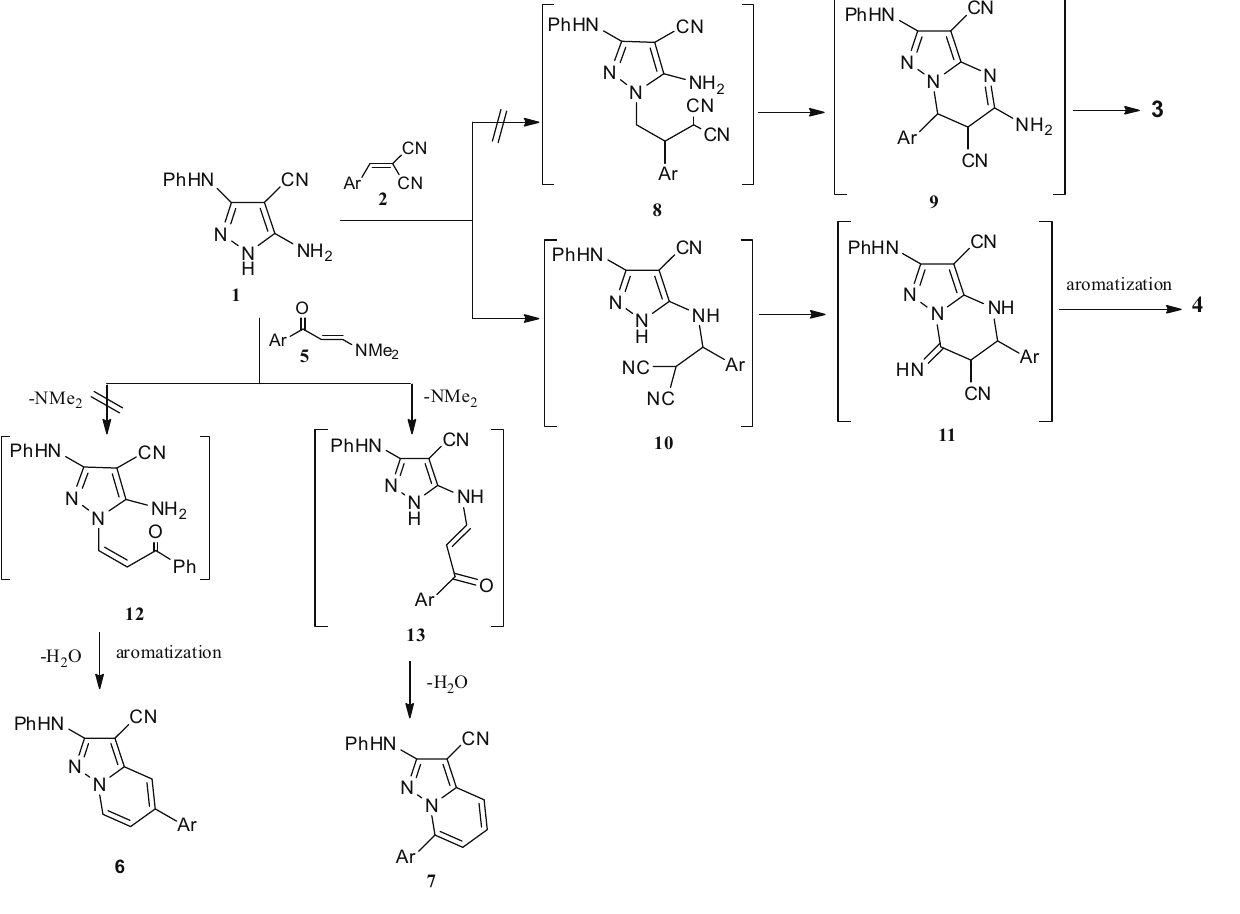
Scheme 3: Mechanism of the formation of 4af and 7a – d